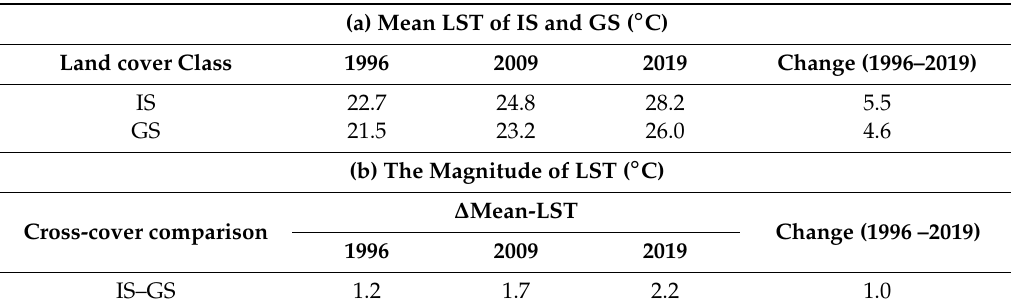
Table 2. Mean LST for the impervious surfaces (IS) and the green surface (GS), and the magnitude of urban heat island (UHI) in °C.